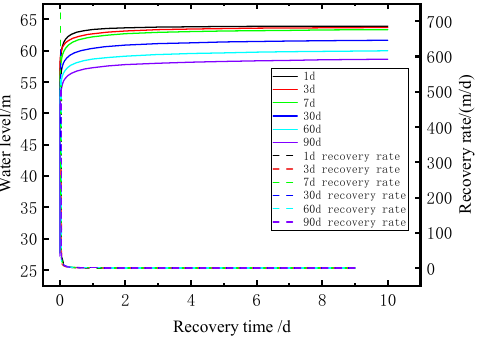
Figure 6. Water level recovery.